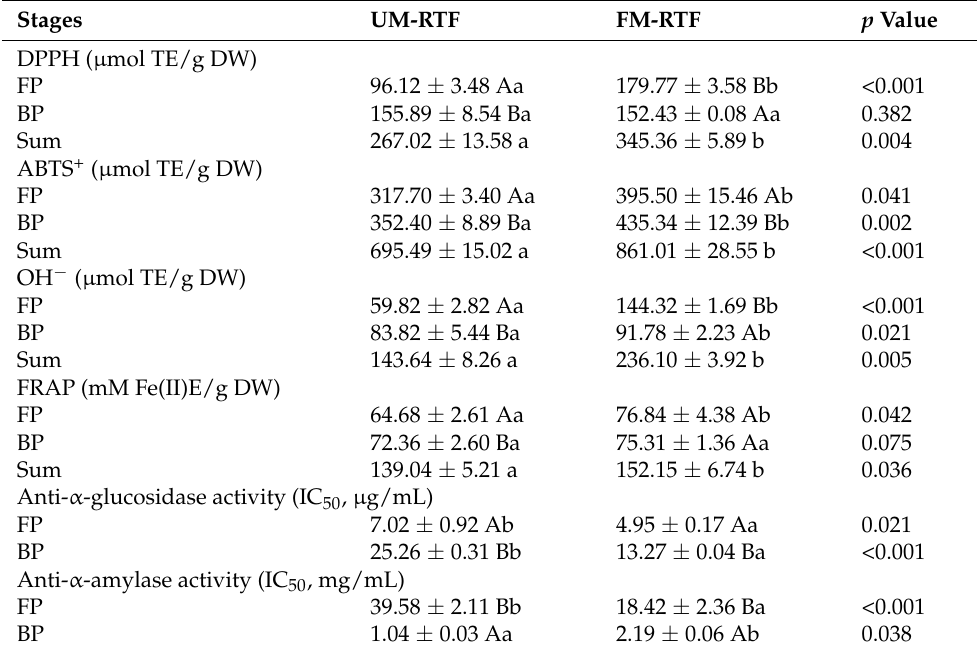
Table 4. Antioxidant activities and digestive enzyme inhibitory activity (IC 50 ) of R. tomentosa fruit in two ripening